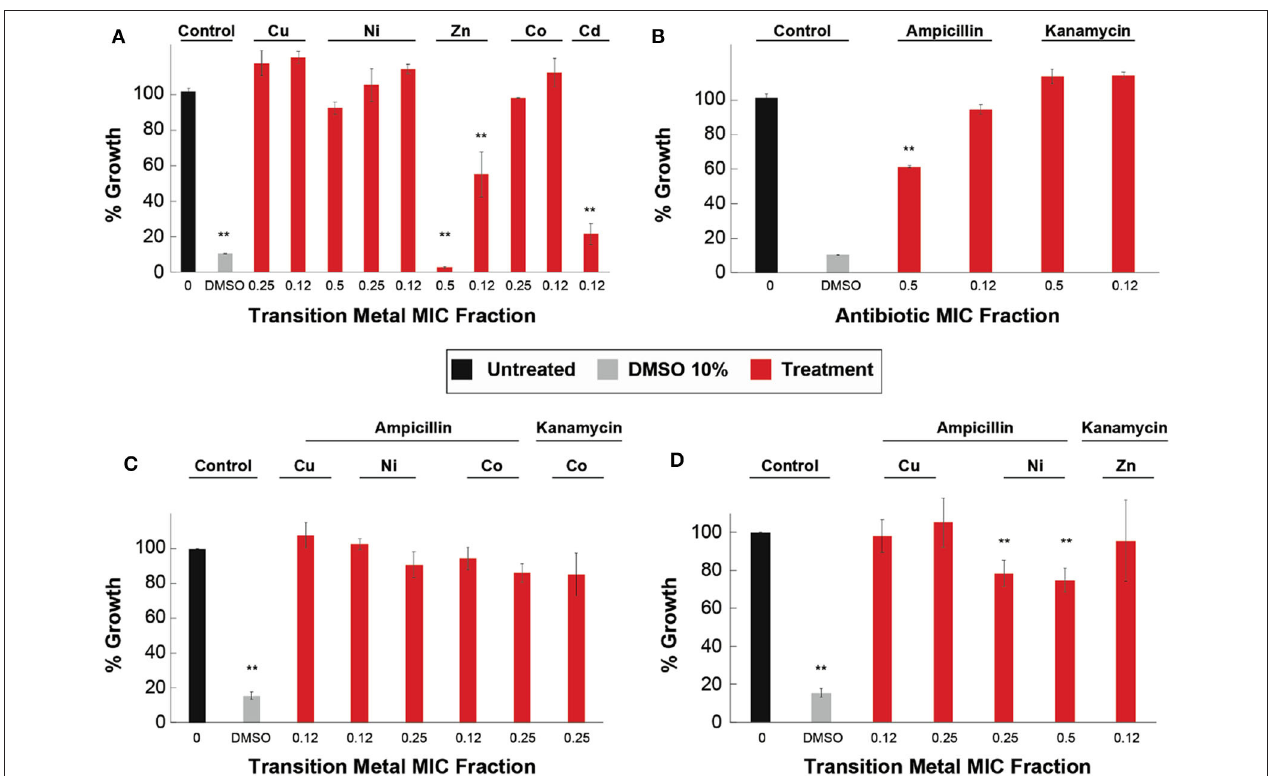
FIGURE 1 | Cytotoxicity of metal ions, antibiotics, and ATMCs on HaCat cells. The effect in cell viability of HaCat cells when exposed to (A) transition metal ions, (B) antibiotic at resistant strains concentrations, (C) ATMCs of susceptible E. coli strain, and (D) ATMCs of resistant E. coli strains. **Corresponds to a significant difference ( p < 0.05) concerning the control and each of the individual treatments. Error bars correspond to the standard deviation from experiments performed in triplicates.